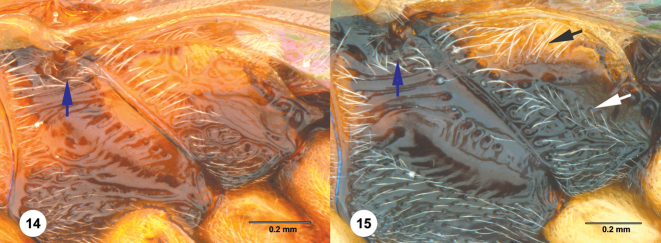
Mesopleuron and metapleuron 14Chromoteleiaconnectens Kieffer, female, holotype (CAS TYPE9618) 15Chromoteleialongitarsis Kieffer, female (OSUC584896).